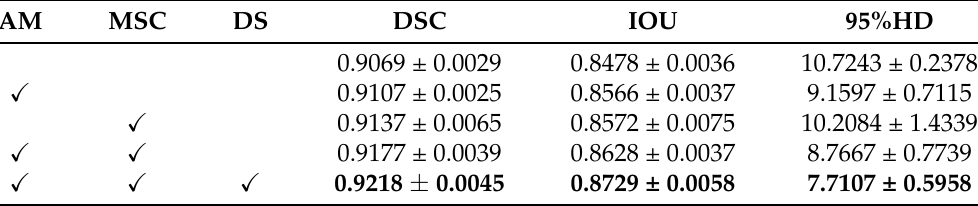
The best performances are